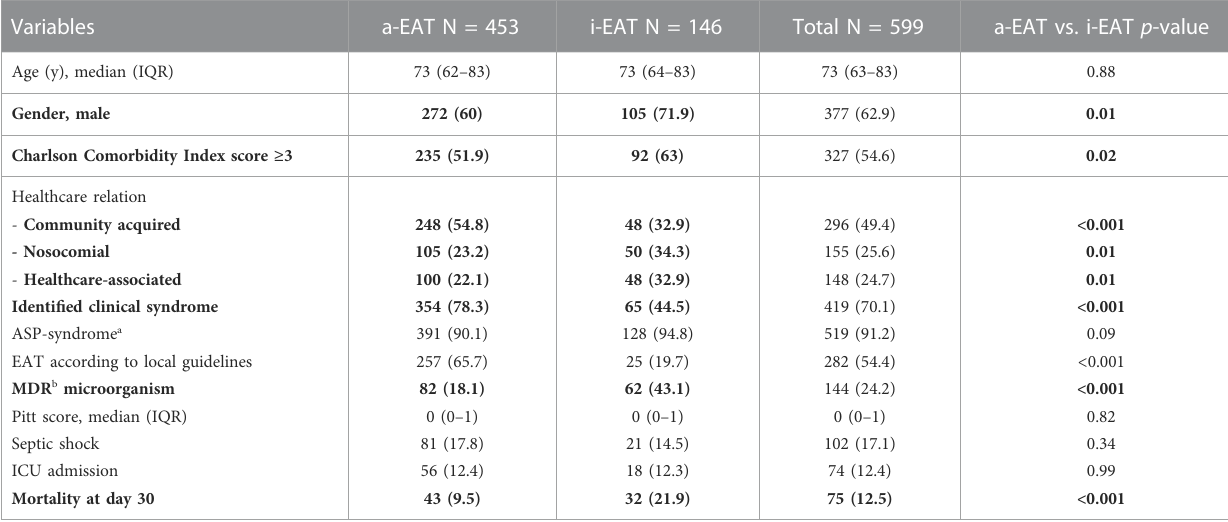
TABLE 1 General characteristics of the BSI episodes, and comparison between a-EAT and i-EAT. Variables